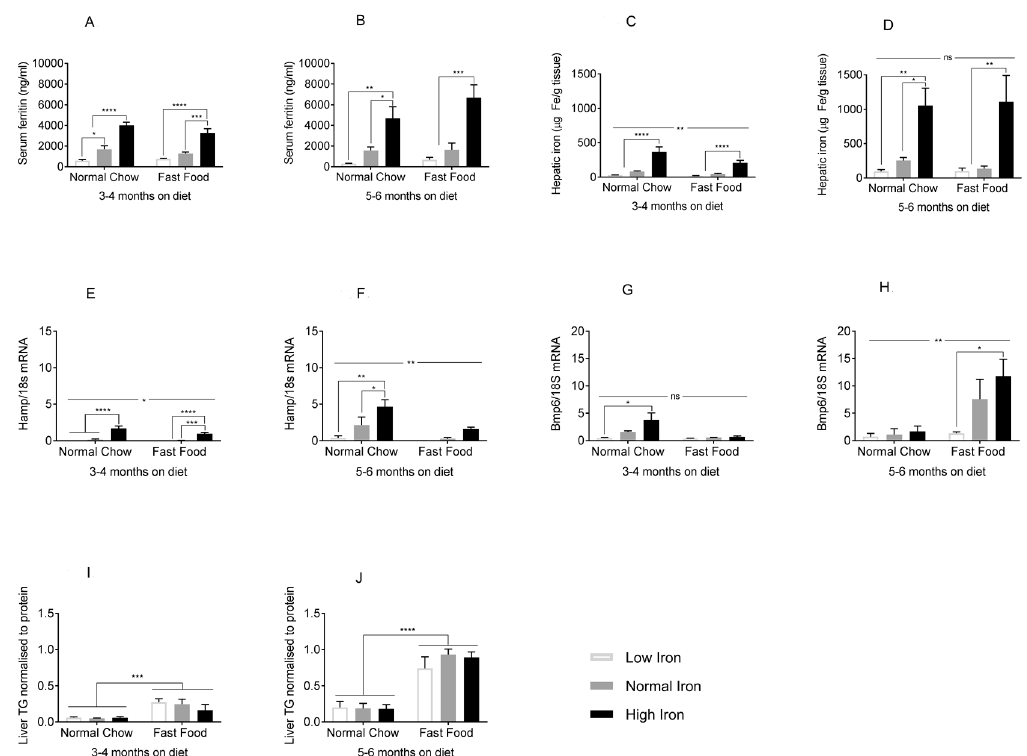
Figure 3. E ff ects of the FF diet on iron parameters and of dietary iron on hepatic lipid accumulation. ( A , B ) Serum ferritin at 3–4 and 5–6 months ( n = 3–5 per group). ( C , D ) Hepatic iron content at 3–4 and 5–6 months ( n = 3–6 per group). ( E , F ) Hepcidin mRNA (Hamp) normalized to 18s rRNA at 3–4 and 5–6 months ( n = 3–5 per group). ( G , H ) Bone morphogenetic protein 6 (Bmp6) mRNA at 3–4 and 5–6 months ( n = 3–5 per group). ( I , J ) Liver triglyceride content (TG) at 3–4 and 5–6 months ( n = 3–10 per group). Shown are means ± SE. p values were calculated by two-way ANOVA with post hoc Tukey’s multiple comparisons test. ns: not significant, i.e., p ≥ 0.05; * 0.01 ≤ p ≤ 0.05; ** 0.001 ≤ p ≤ 0.01; *** 0.0001 ≤ p ≤ 0.001; **** p < 0.0001.